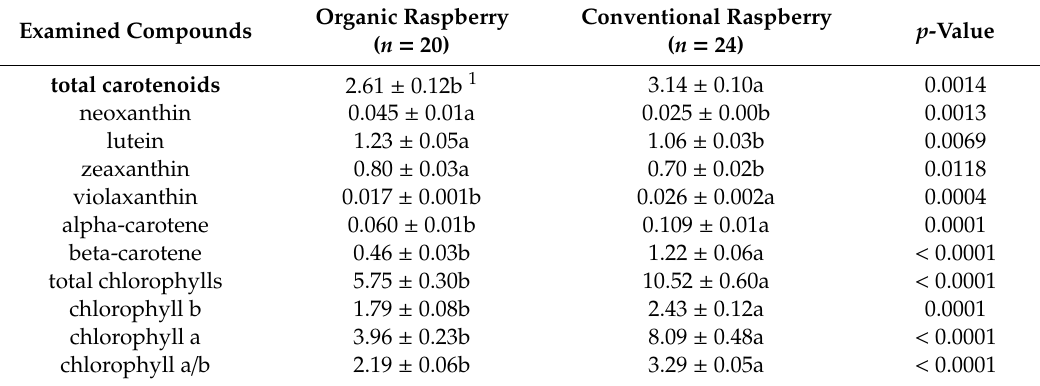
Table 4. The content of carotenoids (mg 100 g − 1 FW) and chlorophylls (mg 100 g − 1 FW) in examined raspberry leaves depending on cultivation system. Data are presented as the mean ± SE with ANOVA p -value.